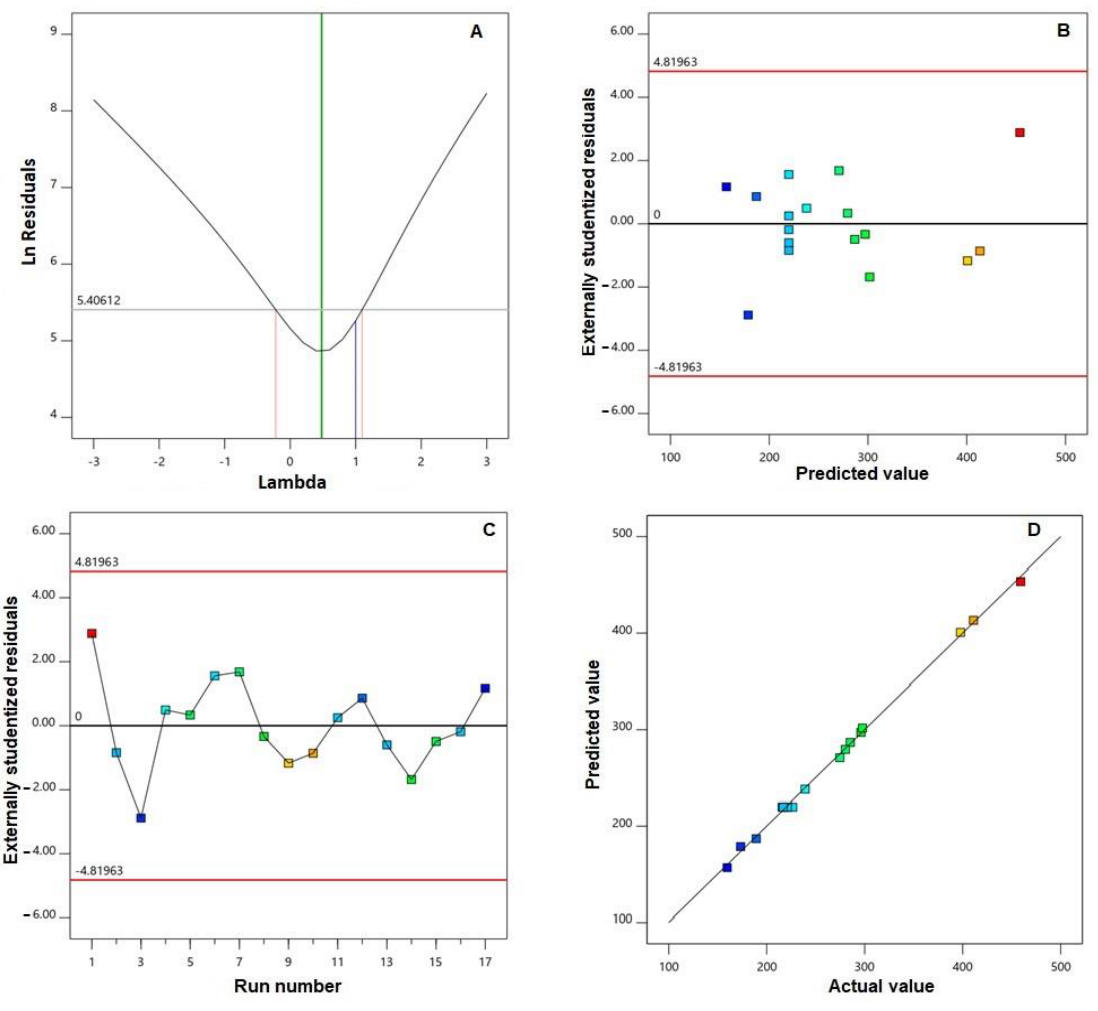
Figure 1. Diagnostic plots for globule size of PIC-BZ: ( A ) Box–Cox plot for power transforms, ( B ) externally studentized residuals vs. predicted values plot, ( C ) externally studentized residuals vs. run number plot, and ( D ) predicted vs. actual values plot.